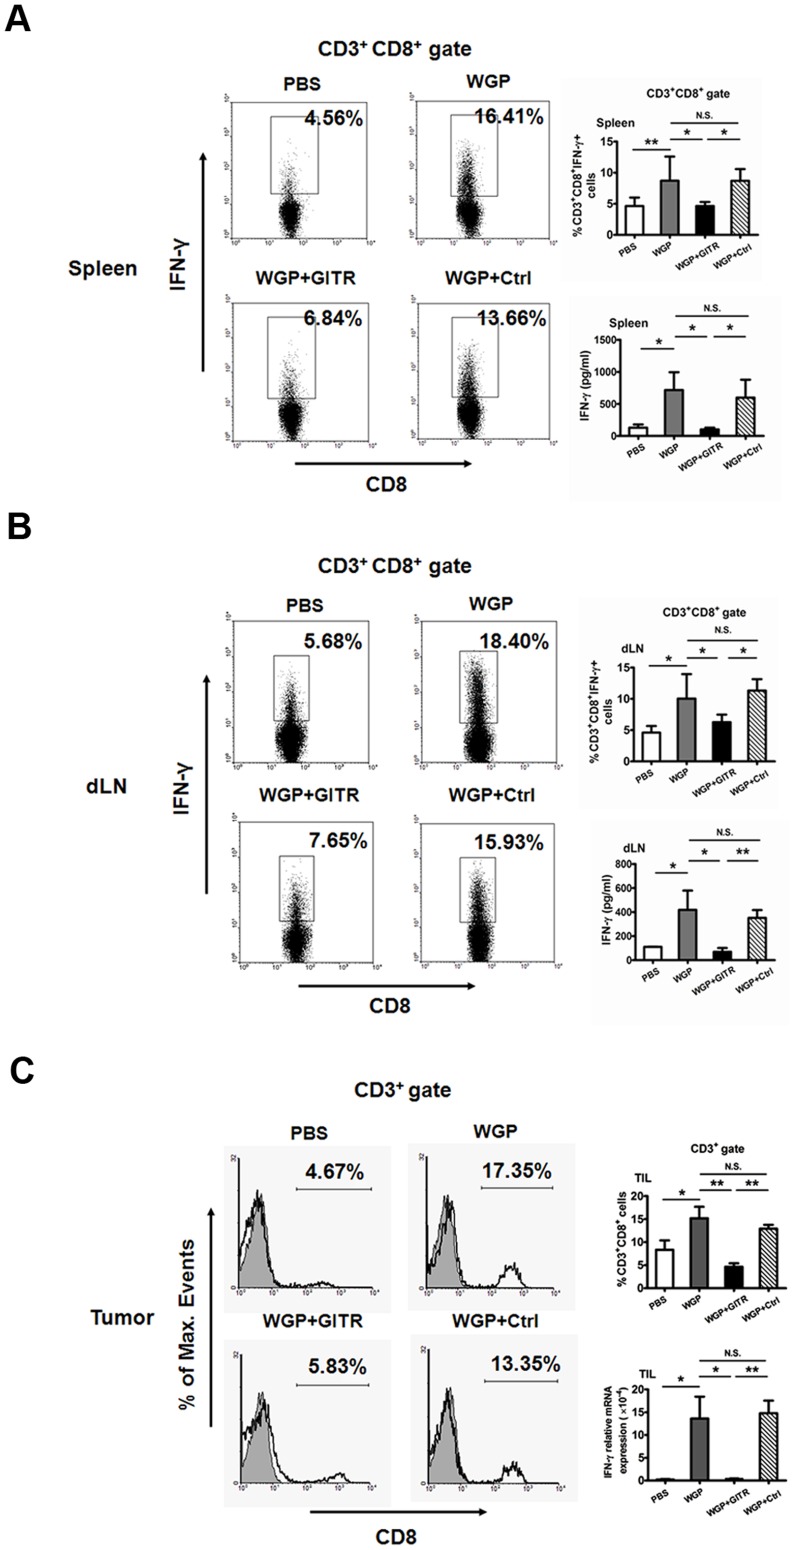
WGP induces enhanced CTL priming in vivo.Groups of mice (n = 6) bearing established Lewis lung carcinoma were treated as described in Materials and Methods. (A, B) Single cell suspensions prepared from spleens (A) and draining lymph nodes (B) were stimulated with PMA plus ionomycin and stained intracellular IFN-γ. Cells were gated on CD3+CD8+ T cells. Culture supernatants from splenocytes and lymphoid cells were collected and assayed for IFN-γ using ELISA. (C) Tumor specimens from each group were prepared for single cell suspensions. Cells were stained with mAbs against CD3, CD8 and were assessed by flow cytometry. Cells were gated on CD3+ T cells. RNAs from tumor specimens were extracted and qRT-PCR was performed for IFN-γ. Results are expressed as mean ± SD. **P<0.01, *P<0.05, N.S. represents no significance between columns.